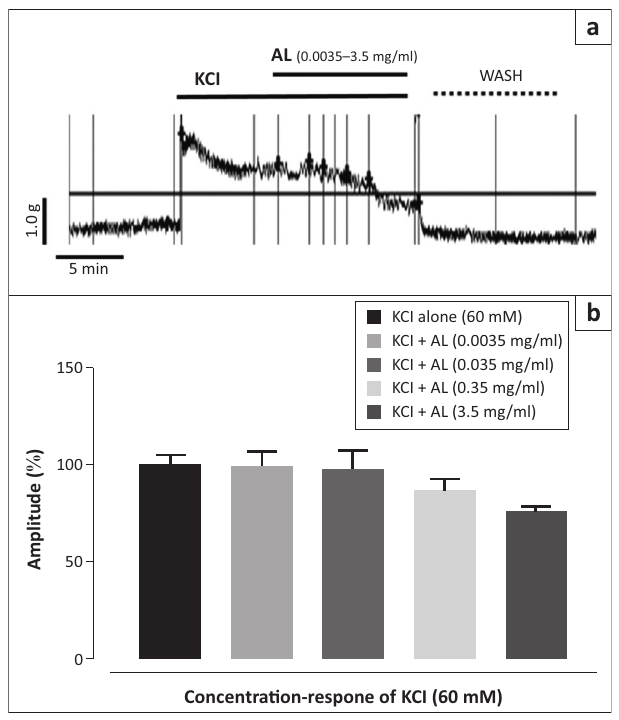
FIGURE 4: Effect of Alchornea laxiflora (AL) on high KCl-induced (60 mM) uterine contraction. Figure a depicts original recording representative of the effect of AL on high KCl-induced contraction. Figure b represents bar graph analysis of the effect of AL on high KCl-induced uterine contraction. Alchornea laxiflora (0.0035 mg/mL–3.5 mg/mL) was observed to inhibit high KCl-induced uterine contraction in this study (a). The inhibition observed was more pronounced at higher concentrations of 0.35 mg/mL and 3.5 mg/mL, though considered not statistically significant. n = 4 animals.